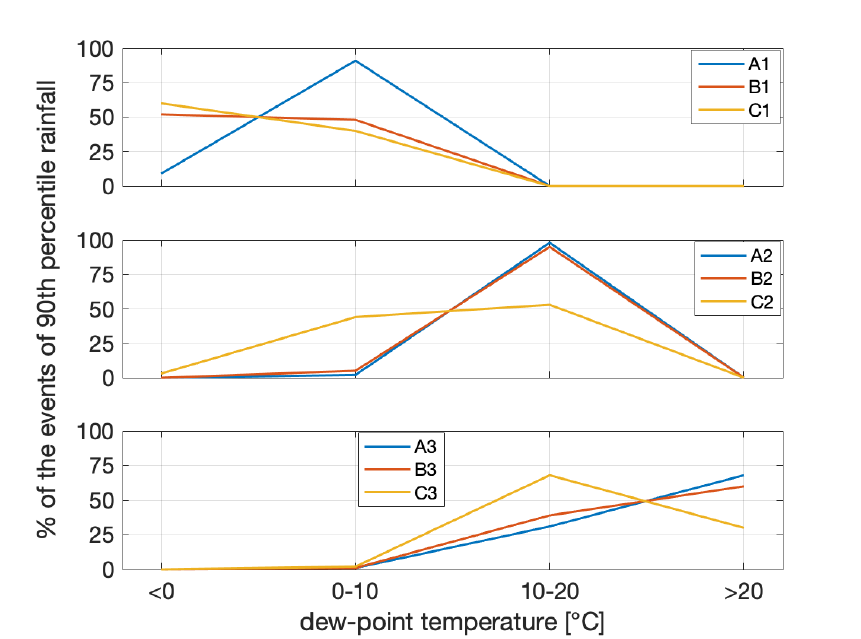
Figure 13. Line plot showing the percentage of the events of 90th percentile rainfall for different value ranges of dew-point temperature. We show higher values of dew-point temperature for most of the events of 90th percentile rainfall over low-elevation foreland and intermediate-elevation areas as compared to Altiplano region.